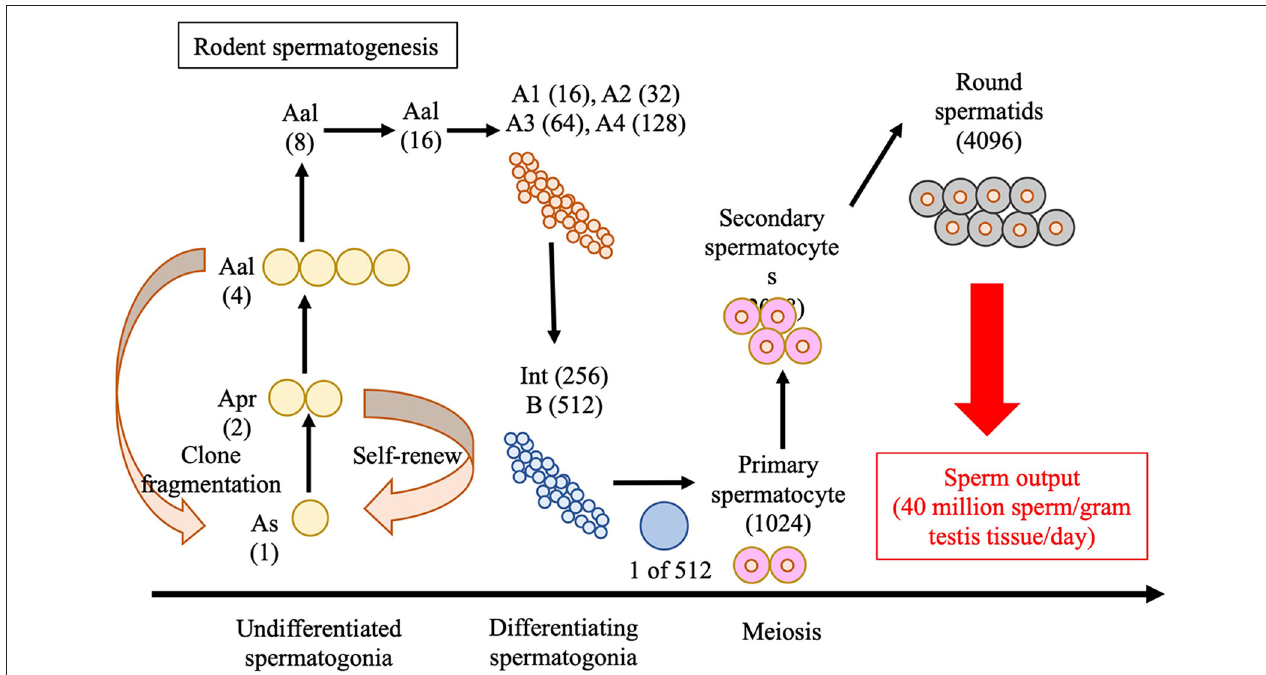
FIGURE 2 | Schematic of spermatogenesis in rodents. “A-single” (As), “A-paired” (Apr), and “A-aligned” (Aal) represent undifferentiated spermatogonia in the 1-, 2-, and 4-cells, respectively. During spermatogenic development, As spermatogonium undergoes one or more mitotic divisions to give rise to larger clones (chains) of interconnected cell sizes through transit-amplifying mitotic divisions. The image features 3–4 transit-amplifying divisions in the pool of undifferentiated As, Apr, and Aal spermatogonia, followed by 6 amplifying divisions in the pool of differentiated spermatogonia (A1–A4, Intermediate, and B-type) that give rise to primary spermatocytes. Two additional meiotic divisions produce the round spermatids that undergo spermiogenesis to produce sperm. Int,